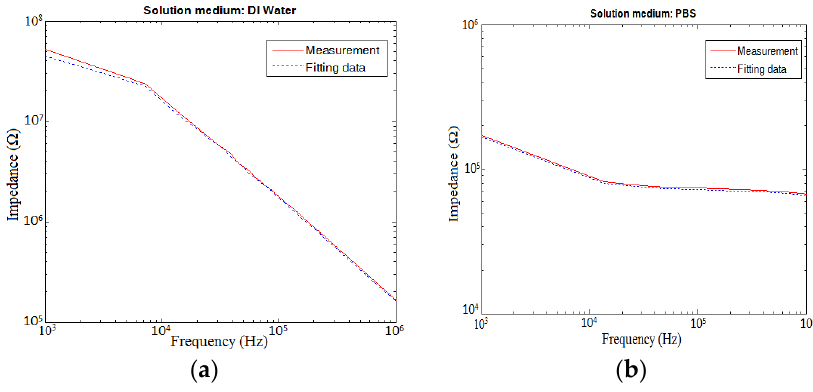
Figure 3. Impedance spectra of sample solution together with their fitting spectra ( a ) deionized (DI) water; ( b ) phosphate-buffered saline (PBS). Appl. Sci. 2017 , 7 , 170